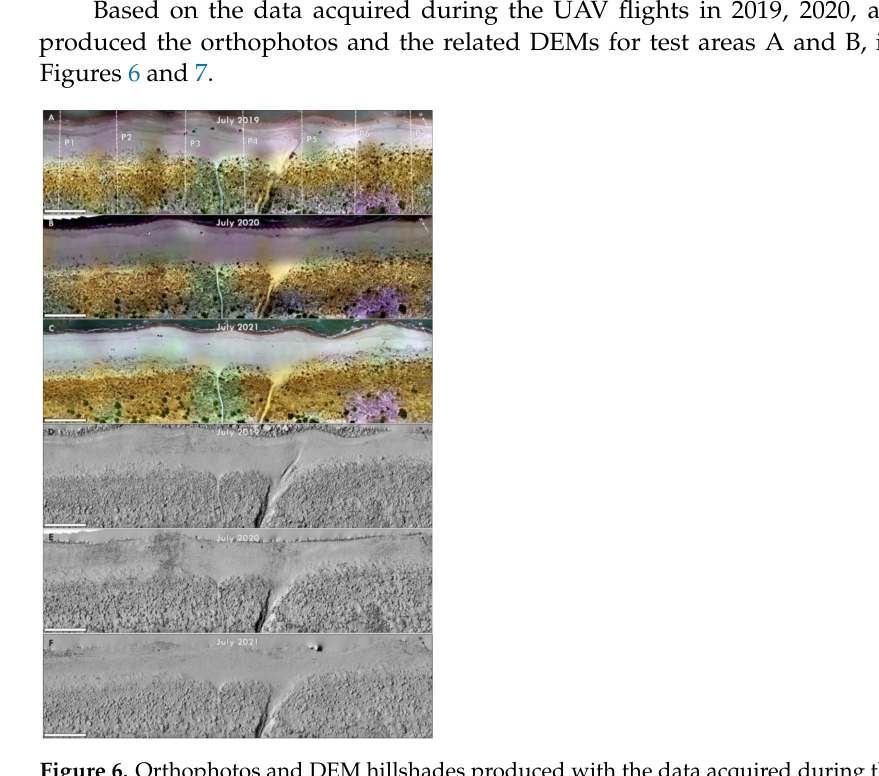
Figure 6. Orthophotos and DEM hillshades produced with the data acquired during the UAV flights in 2019 ( A , D ), 2020 ( B , E ), and 2021 ( C , F ) along Petacciato beach. ( A ) shows the locations of beach profiles P1–P7 extracted from the DEMs.